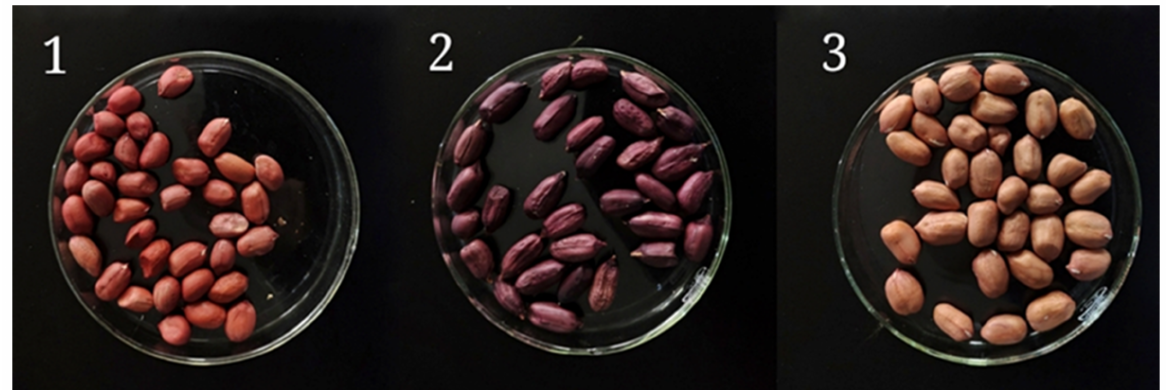
Figure 1. Samples of peanuts from different varieties were used in the study. 1. Silihong, 2. Silihei, 3.